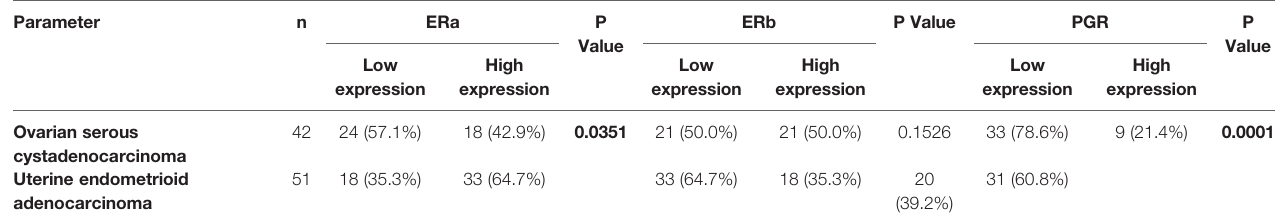
TABLE 1 | Association among ERa, ERb, and PGR protein expression levels in tumor tissues of patients with ovarian serous cystadenocarcinoma and uterine endometrioid adenocarcinoma. Parameter n ERa P